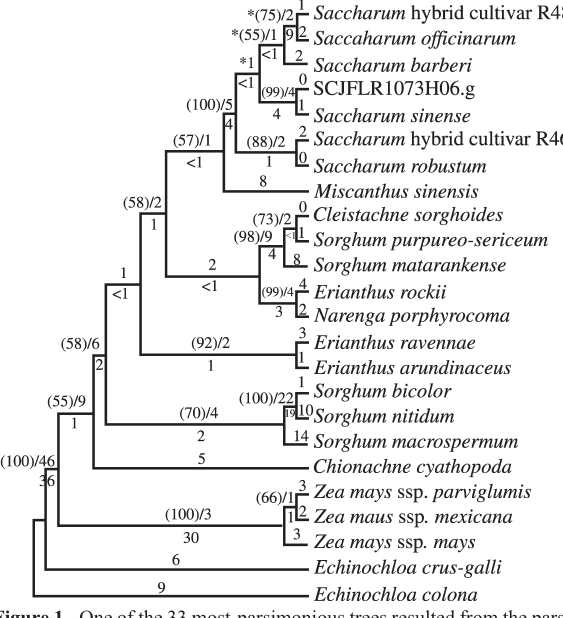
Figure 1 - One of the 33 most-parsimonious trees resulted from the parsi- mony analysis (re-weighting using a rescaled consistency index (RCI)) of 154 informative sites from ITS1-5.8S-ITS2 of 24 Poaceae sequences. Length = 373, consistency index (CI) = 0.7131, retention index (RI) = 0.7902.Numbersinparenthesisabovebranchesindicatebootstrapsupport from 100 replicates with 10 random addition heuristic searches per